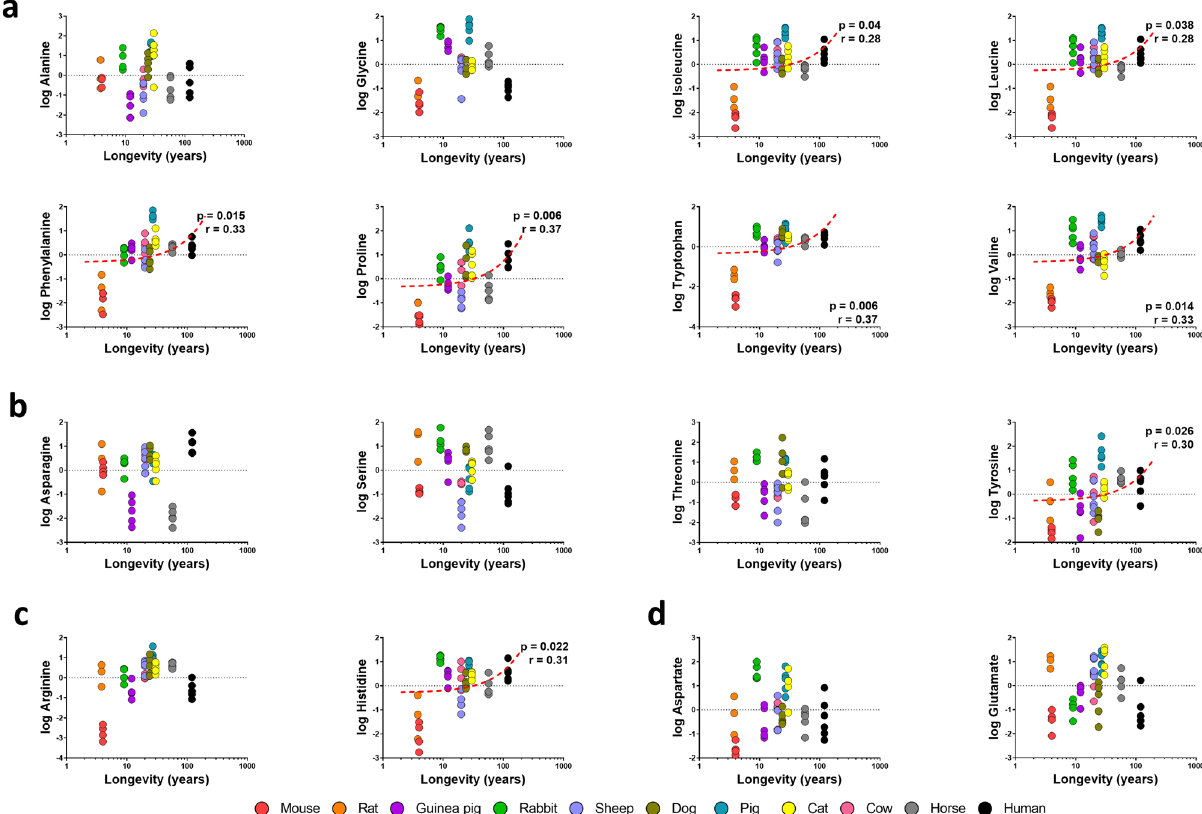
Fig. 4 Individual plasma concentration of the detected amino acids. a Non-polar amino acids. b Polar uncharged amino acids. c Positively charged amino acids. d Negatively charged amino acids. Pearson correlation between plasma metabolites and animal longevity was performed A – D . Minimum signi fi cation level was set at p < 0.05. All metabolites were log-transformed in order to accomplish the assumptions of normality. Data values are obtained from four (mice and cows), fi ve (rats, rabbits, guinea pigs, sheep, dogs, pigs, cats and horses) or six (humans)